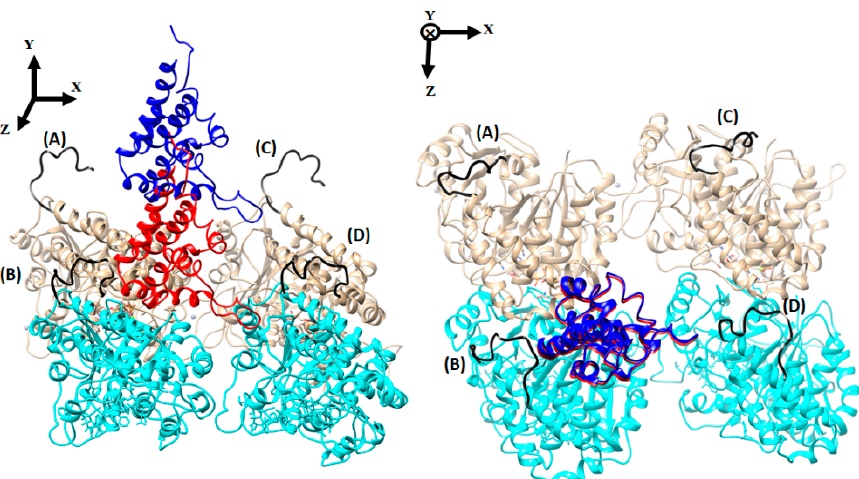
Figure 3. The average number (averaged over three independent molecular dynamics (MD) runs) of E-hook–MTBD contacts as a function of MTBD–microtubule distance and simulation time. (Panels ( a ) and ( c )): The average number of E-hook B –MTBD contacts at various distances for cytoplasmic and axonemal MTBDs, respectively. (Panels ( b ) and ( d )): The average number of E-hook D –MTBD contacts at various distances for cytoplasmic and axonemal MTBDs, respectively. For all panels, the bound position (gray plot) corresponds to distance 0 Å, and the MTBD–microtubule distances of 5 Å, 15 Å, 25 Å, 45 Å, and 55 Å are plotted as indicated in the legend. Note that only the snapshots of the last 10 ns (Nano-second) of a total 20 ns of simulation time are plotted.